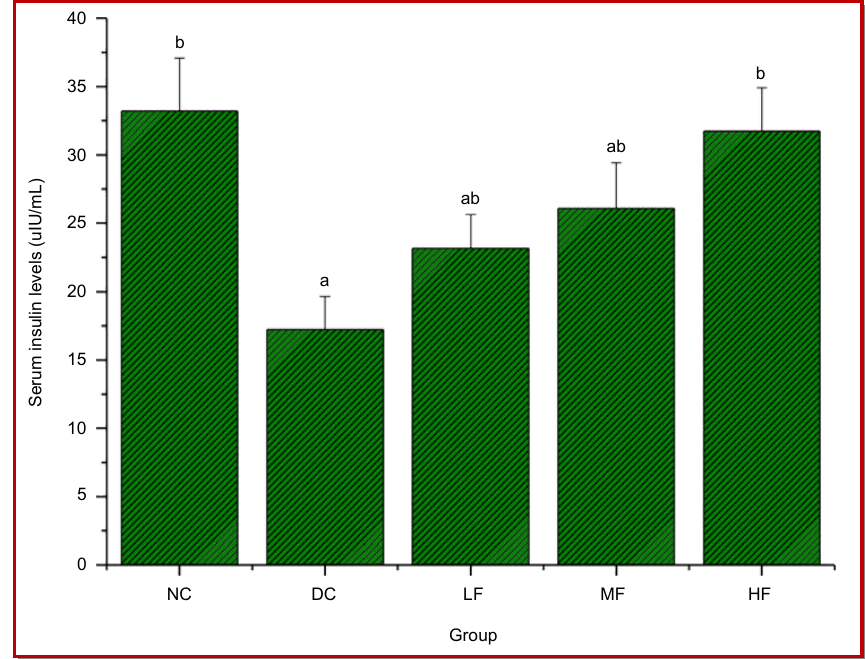
Figure 2: Effects of FTB on serum insulin levels in mice. Data were presented as means ± SD. a p<0.05 as compared with the NC group. b p<0.05 as compared with the DC group; NC means normal control; DC means diabetic control; Diabetic mice received low dose (LF) , middle dose (MF) and high dose (HF) of FTB